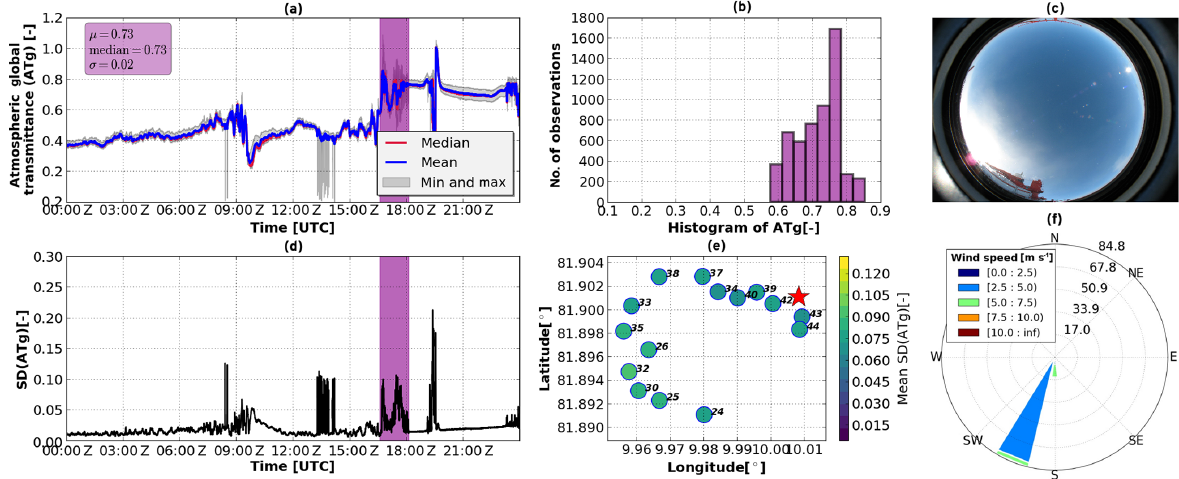
Figure 9. Overview of thin cloud case: the same as Fig. 6 but for 9 June 2017, 16:36–18:08Z. All-sky camera photograph taken at